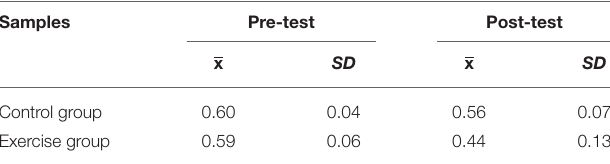
TABLE 2 | Descriptive statistics of depression at pre- and the post-test for the total sample and by